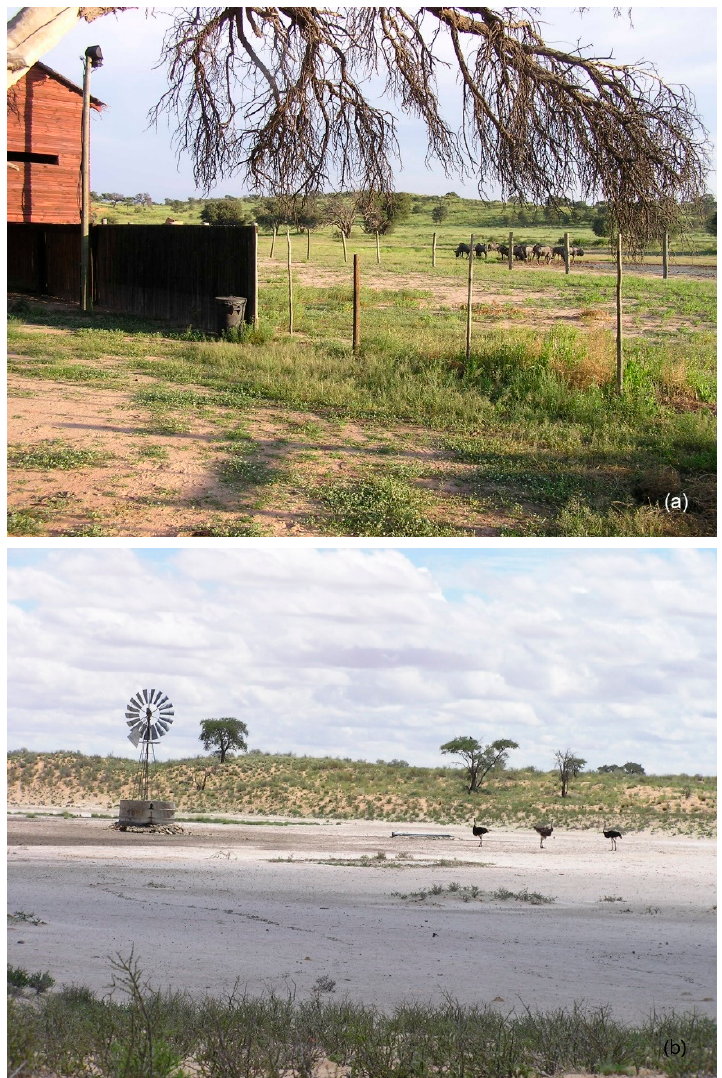
Figure 2. ( a ) Hide with night illumination overlooking a watering point in the Kgalagadi Transfrontier Park in South Africa. ( b ) Bore supplying water to fauna in Kgalagadi Transfrontier Park (Images: D.B. Croft).